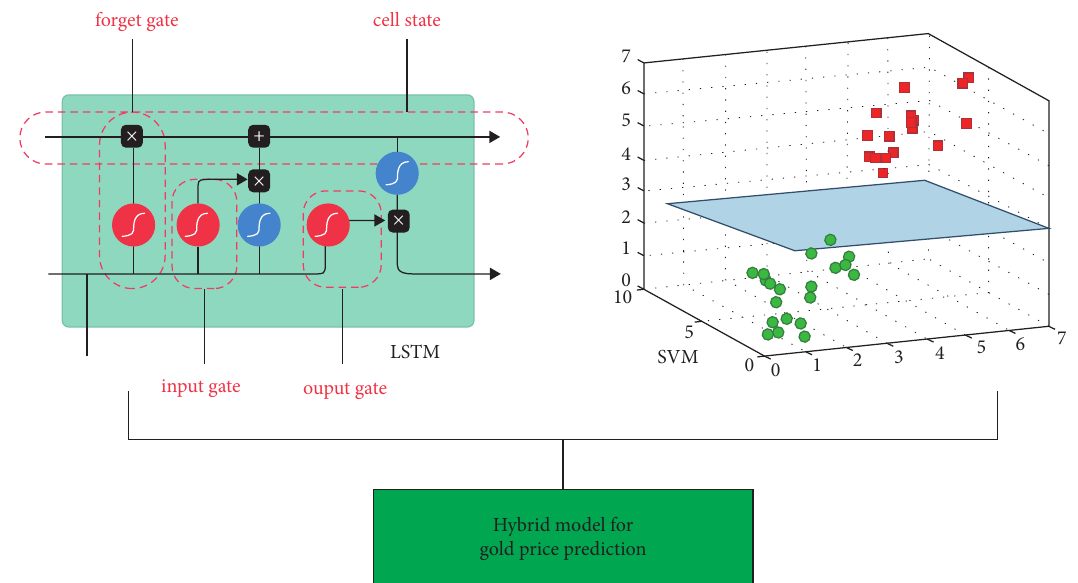
Figure 1: The illustration of the prediction model of gold